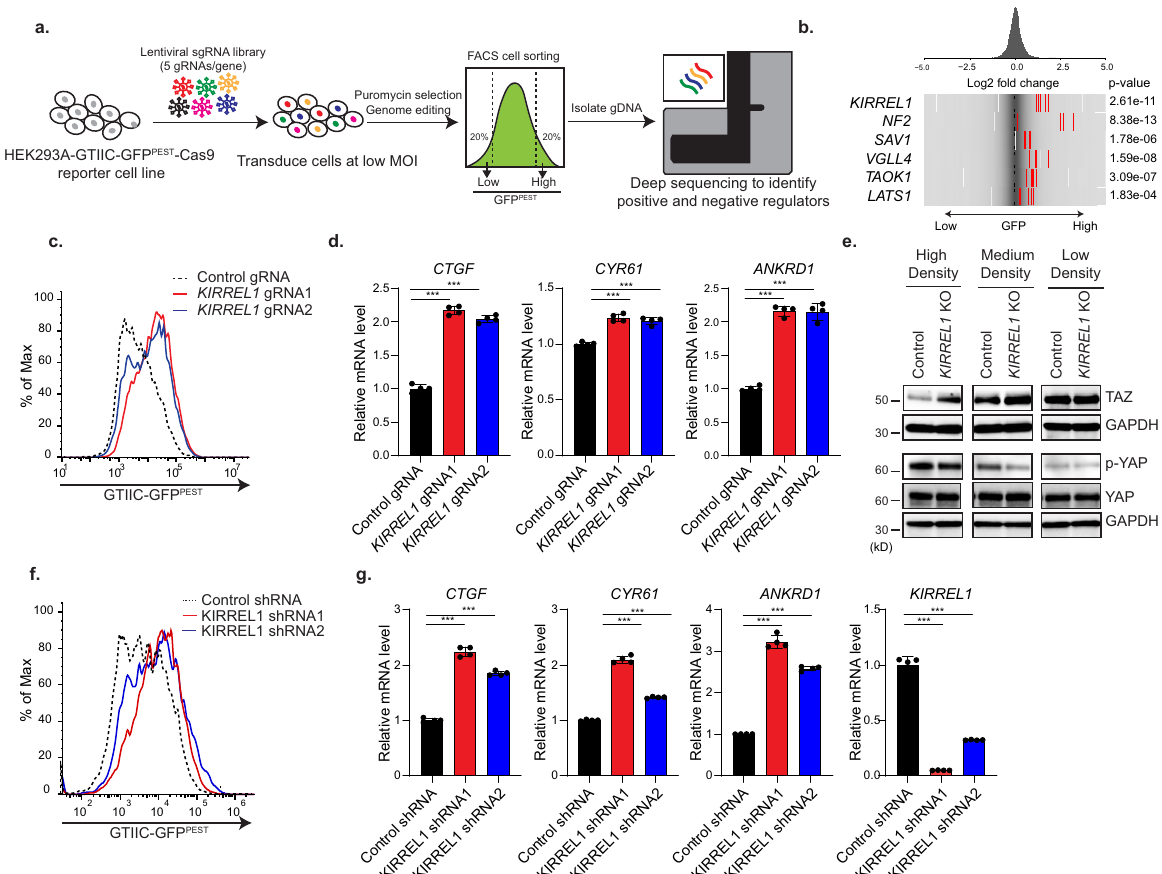
Fig. 1 Genome-wide pooled CRISPR screen identi fi ed KIRREL1 as a positive regulator of Hippo pathway. a Schematic of FACS-based pooled CRISPR screen to identify positive regulators of Hippo pathway in HEK293A GTIIC-GFP PEST Cas9 cells. b Frequency histograms of gRNAs identi fi ed in the high GFP PEST population of HEK293A GTIIC-GFP PEST pooled CRISPR screen. The RSA p -value is shown along with log2 fold change for each of the fi ve gRNAs per gene for the indicated set of genes. gRNAs targeting the indicated genes are shown by the red lines. c Knockout of KIRREL1 by independent gRNAs enhances GTIIC-GFP PEST reporter activity in FACS assay. HEK293A GTIIC-GFP PEST Cas9 cells transduced with lentivirus expressing RFP and control or KIRREL1 gRNAs were mixed with parental cells at 1:3 ratio, co-cultured for 2 days, and subjected to FACS analysis. The signal of GTIIC-GFP PEST in RFP- positive cells is plotted. d Knockout of KIRREL1 increases YAP target gene expression in HEK293A cells. HEK293A GTIIC-GFP PEST cells expressing control or KIRREL1 gRNAs were plated at medium density (0.5 × 10 6 cells/well) in 12-well plate and subjected for qRT-PCR analysis 48 h of post cell plating. The data represent mean ± SD, n = 4, error bars denote the SD between four biological replicates; Unpaired two-tailed t -test was used to determine the statistical signi fi cance *** p value < 0.001. e Knockout of KIRREL1 increases the protein level of TAZ and decreases YAP phosphorylation in HEK293A cells. Control and KIRREL1 knockout cells were plated at high (1 × 10 6 cells/well), medium (0.5 × 10 6 cells/well), or low (0.25 × 10 6 cells/well) density in 12-well plate and subjected to western blot analysis 24 h of post cell plating. GAPDH was used as loading control. f Depletion of KIRREL1 using Dox-inducible shRNAs leads to increased GTIIC-GFP PEST reporter activity. HEK293A-GTIIC-GFP PEST cells stably expressing control or two independent Dox-inducible shRNAs targeting KIRREL1 and subjected to FACS analysis following 96 h of Dox treatment. g Depletion of by shRNA increases expression of YAP target genes in HEK293A cells. The data represent mean ± SD, n = 4, error bars denote the SD between four biological replicates; Unpaired two-tailed t -test was used to determine the statistical signi fi cance, *** p value < 0.001. Source data for Fig. 1d, e, g are provided as Source Data fi TAZ protein (Fig. 2a), increased YAP phosphorylation (Fig. 2a), mutant was higher than full-length KIRREL1 as measured by decreased YAP nuclear accumulation (Fig. S2a), and inhibited western blot (Fig. S2c) and FACS analysis (Fig. S2d), over- YAP-mediated GTIIC-luciferase reporter activity (Fig. S2b). expression of the KIRREL1 Δ ICD mutant failed to inhibit YAP- mediated GTIIC-luciferase reporter activity (Fig. 2e). Together, these data suggest that KIRREL1 functions as a positive regulator